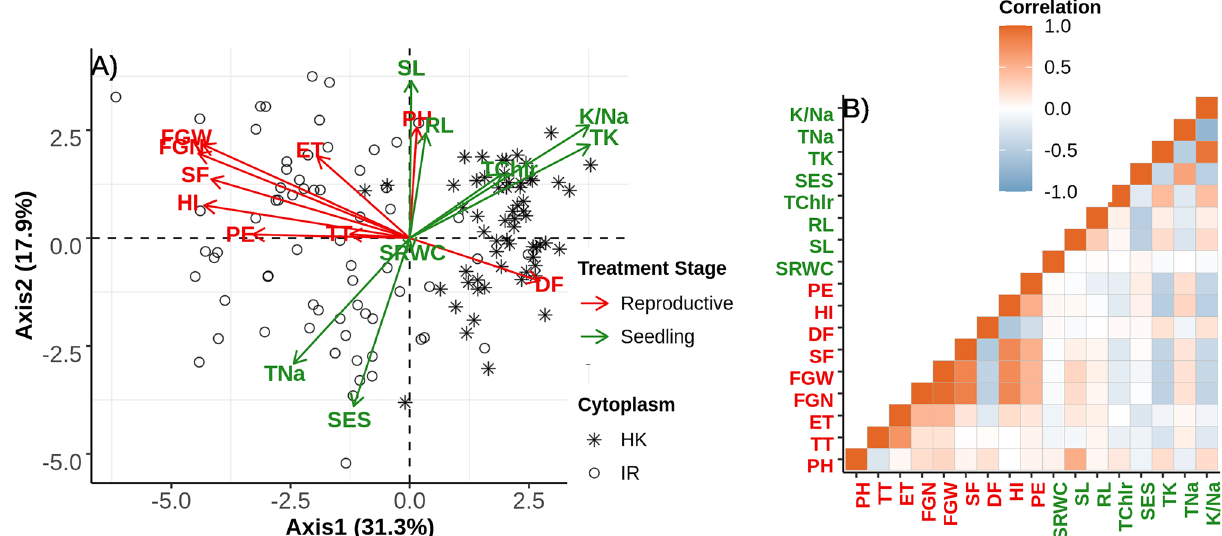
Figure 2. ( A ) PCA on trait correlations in the F 2 mapping population. Each point represents the genetic means of each F 2 family whereas the shape of point indicates the cytoplasm (cross direction). Direction of variation for axis 1 and 2 of each trait has been plotted as arrow and are color labelled depending on two different treatment stages: green indicates Seedling stage treatment and red indicates reproductive stage treatment. Labels of traits are printed close to the arrow-head. ( B ) Plot shows the correlations of traits where brown color shows positive correlation and light-blue indicates negative correlation. Traits labelled with green color indicates seedling stage ones and red indicates reproductive stage